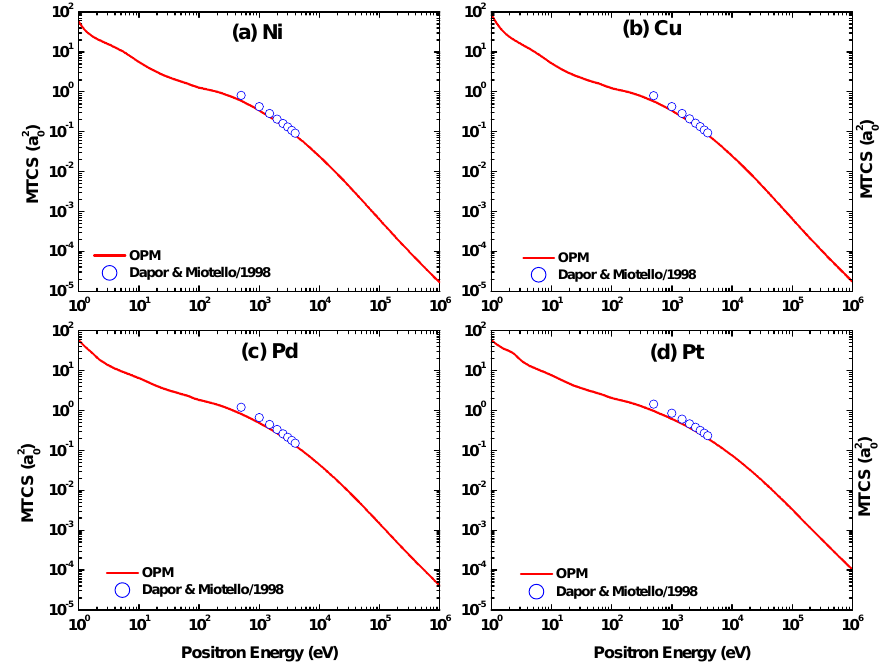
Figure 37. The present OPM calculations of the MTCS for positron impact scattering from ( a ) Ni 58 , ( b ) Cu 63 , ( c ) Pd 108 , and ( d ) Pt 196 in comparison with the results of Dapor and Miotello